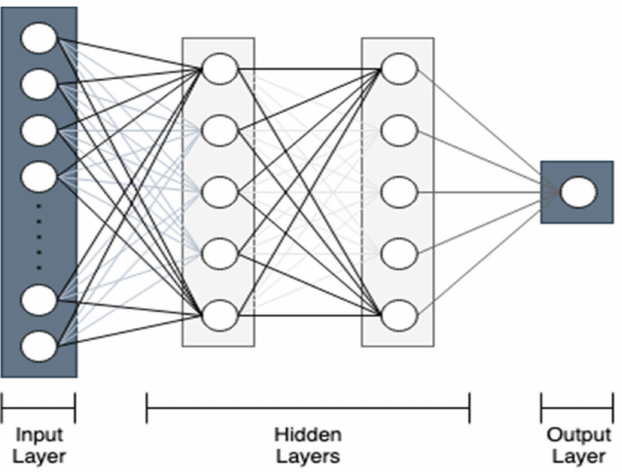
Figure 5. Multilayer perceptron MLP